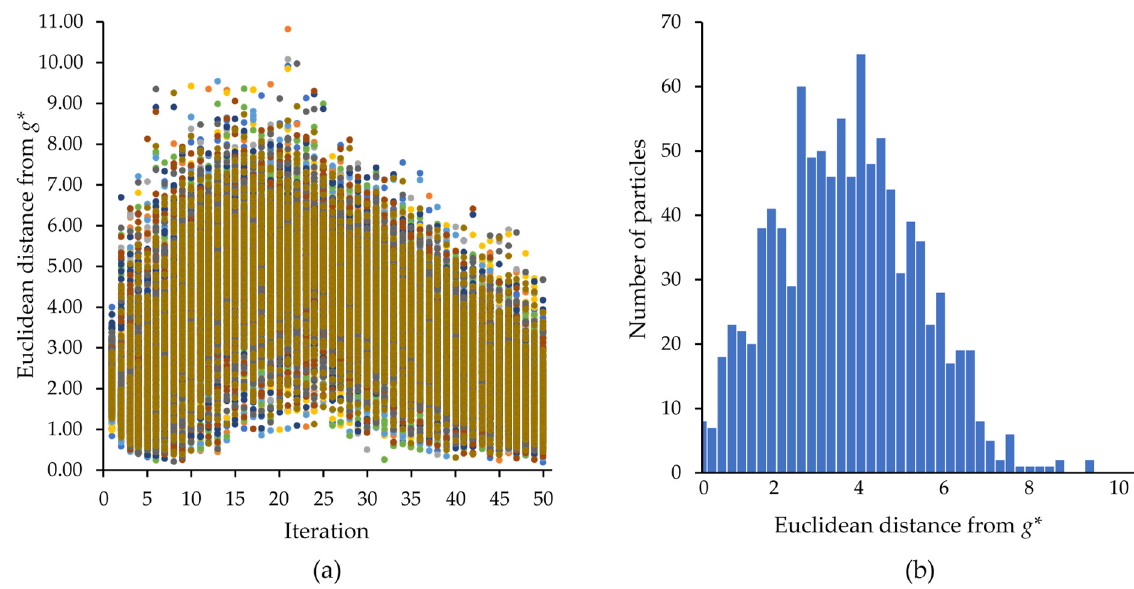
Figure 6. Euclidean distance between the current position of particles and global best position ( g *) recorded from modified particle swarm optimization (MPSO) with 10 particles in 100 test runs: ( a ) From 50 iterations; ( b ) distribution of distance values at 10th iteration.